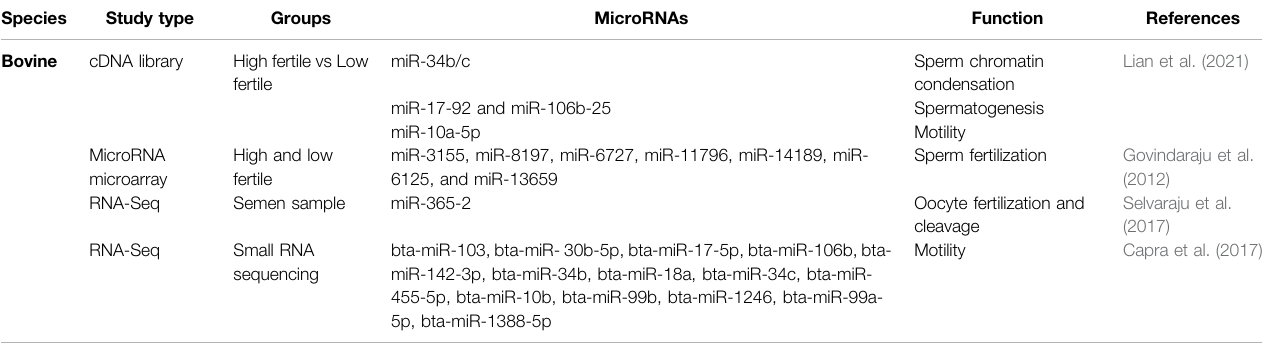
TABLE 3 | Important non-coding microRNAs reported in cattle spermatozoa by transcriptome analysis.